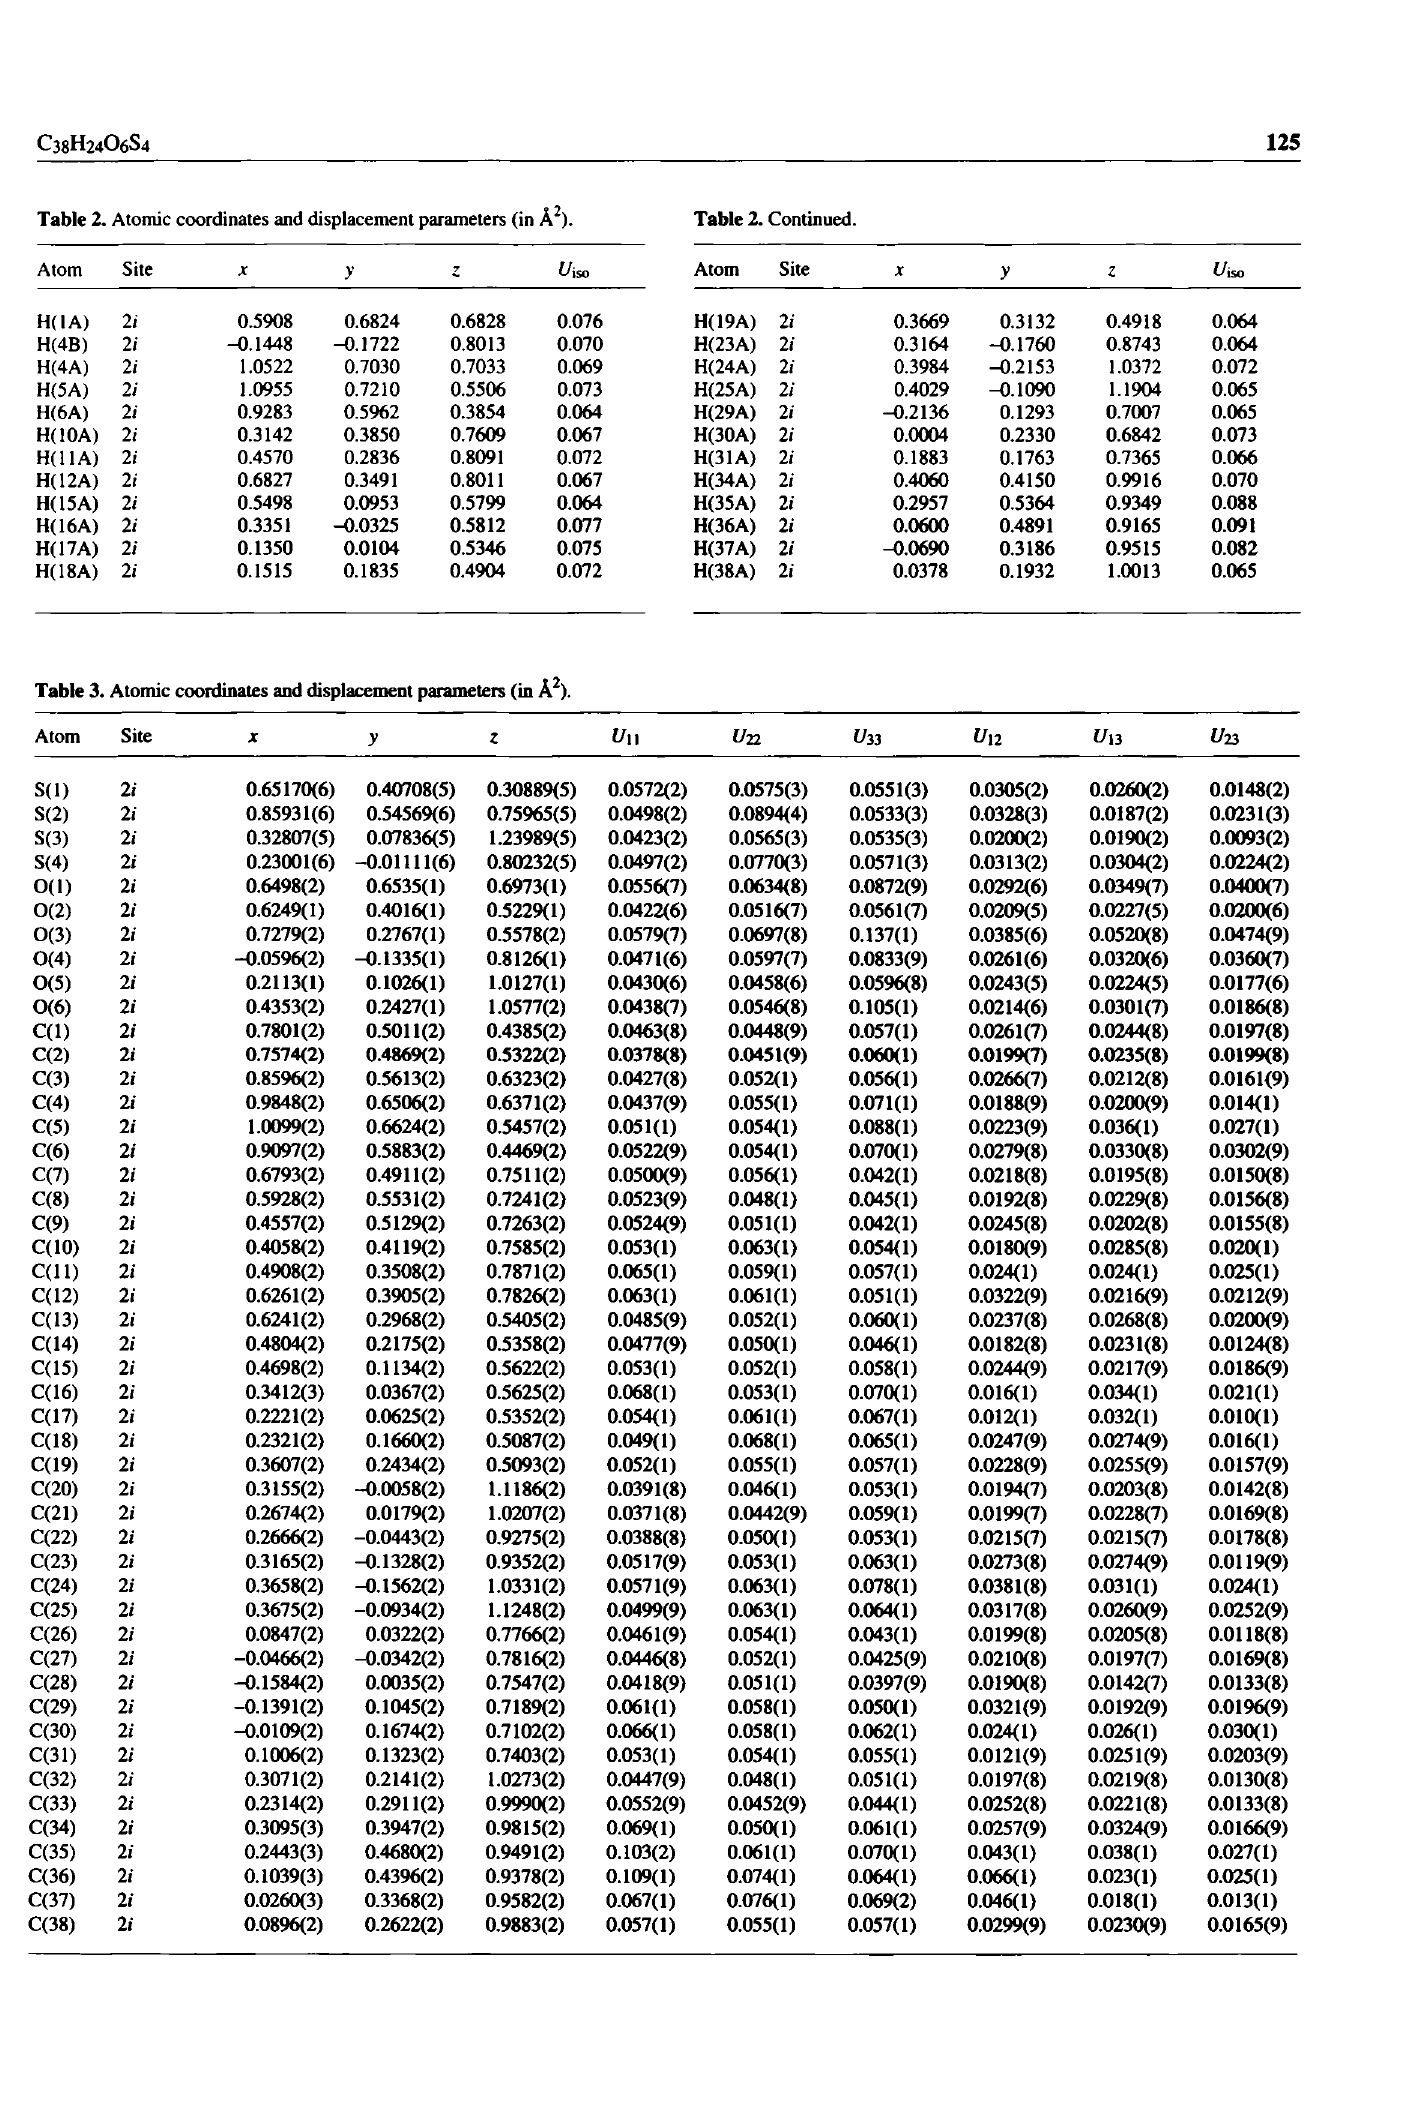
Table 3. Atomic coordinates and displacement parameters (in Â 2